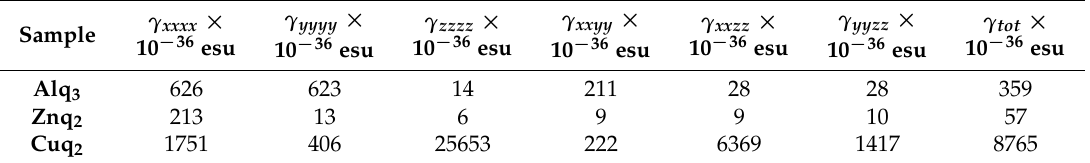
Table 3. Some selected components of the frequency-dependent γ ( − 2 ω ; ω , ω , 0) values at ω = 0.042827 a.u. = 1064 nm.